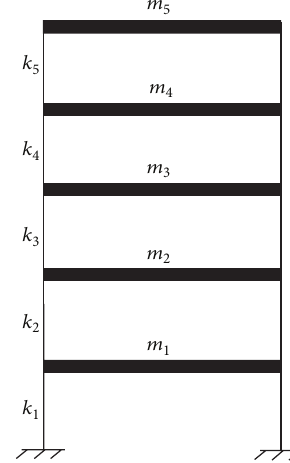
Figure 1: Elevation of a five-story building